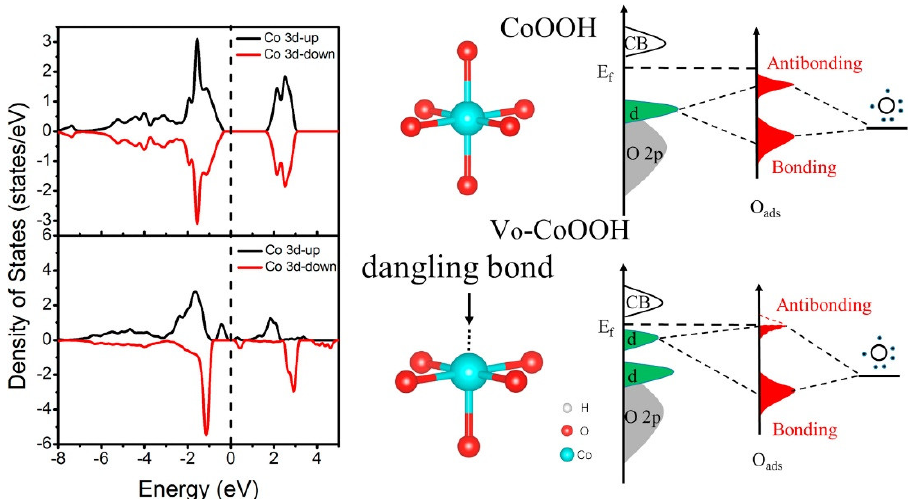
Figure 30. Calculated density of states (DOS) and corresponding schematic bond formation of atomic oxygen through coupling of O 2p to the highest occupied d-state on pristine and oxygen vacancy modified CoOOH. Cyan spheres—cobalt, red—oxygen. (Reprinted from ref. [190] with permission from Nano Energy © 2017, Elsevier).